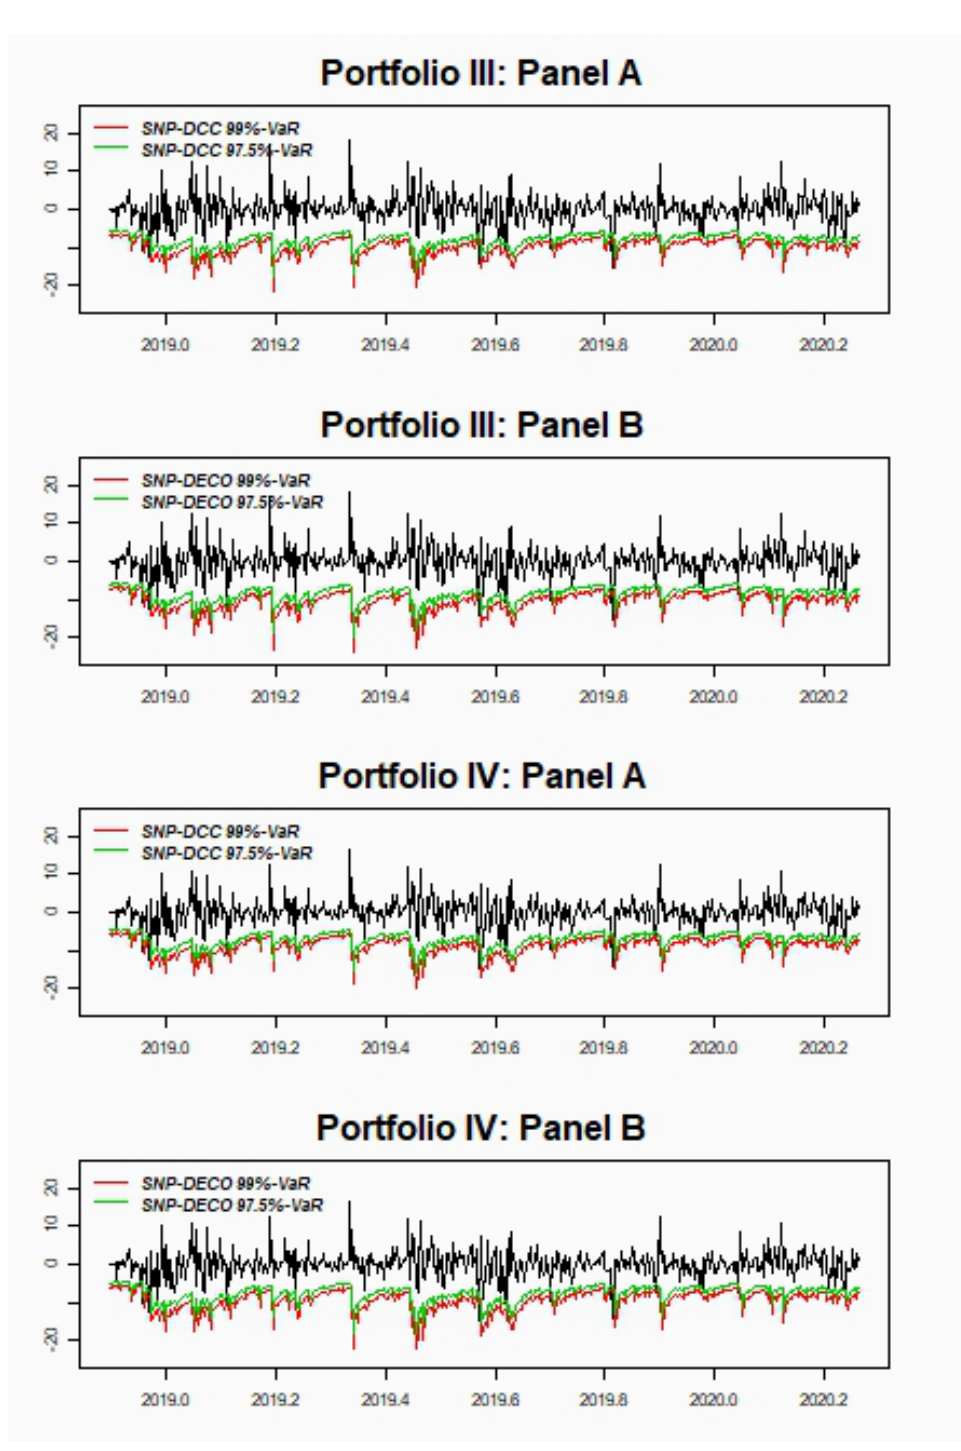
Figure 2. Portfolio returns (black line) compared to 99% Value at Risk (VaR) (red line) and 97.5%-VaR (green line) for the four portfolios with both dynamic conditional correlation (DCC) and dynamic equicorrelation (DECO) models. Portfolio I corresponds to equally weighted portfolio; Portfolio II is 25% Bitcoin (BTC), 25% Litecoin (LTC), and 50% Ripple (XRP); Portfolio III is a combination of 25% BTC, 50% LTC, and 25% XRP; and Portfolio IV is 50% BTC, 25% LTC, and 25% XRP. Panel A ( B ) displays the DCC (DECO) model for every portfolio.